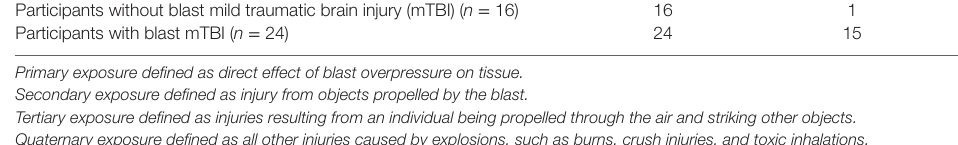
Primary and tertiary